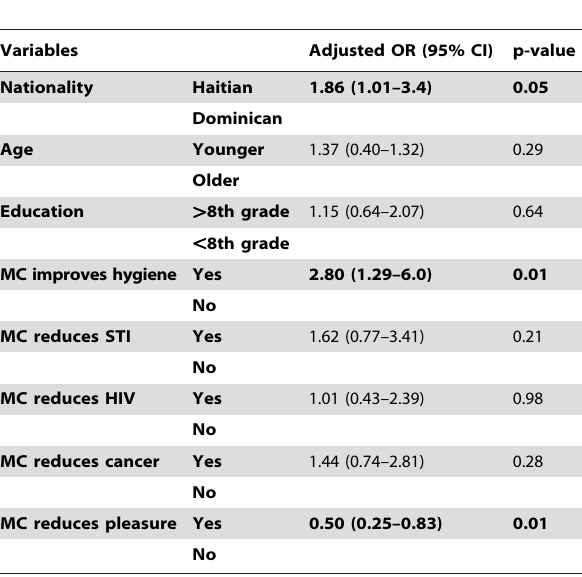
Table 4. Willingness to be circumcised. Multivariate